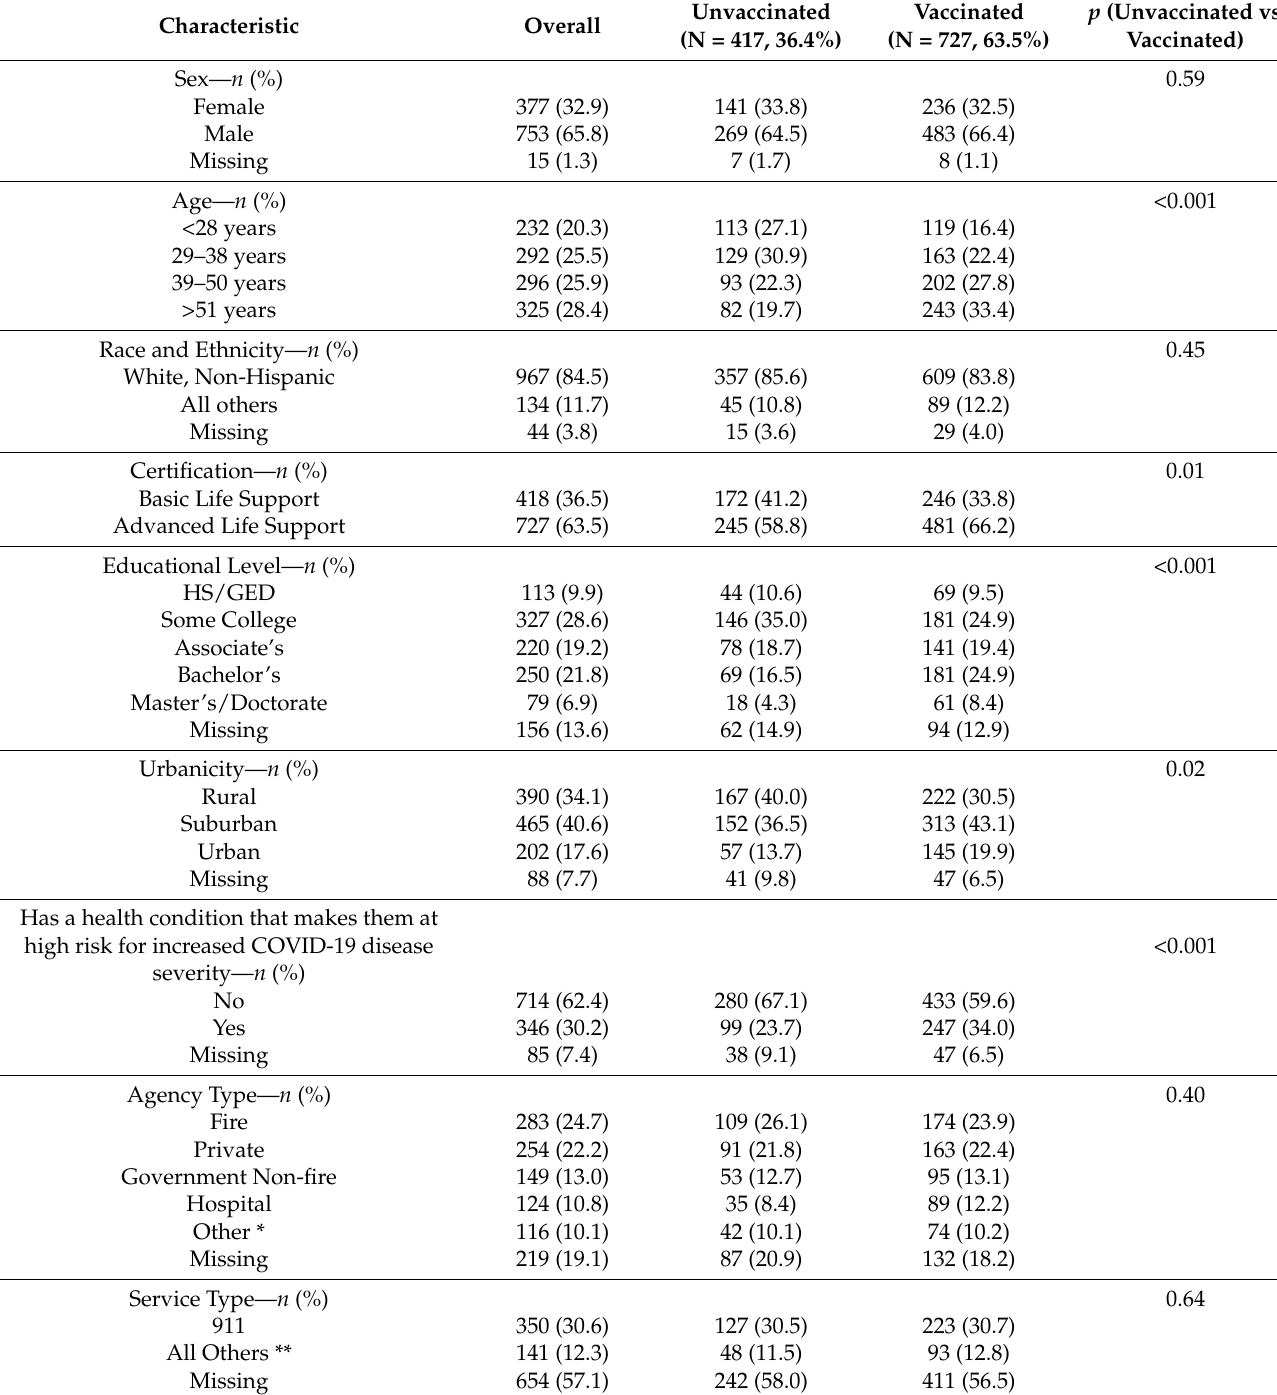
Table 1. Demographics of participants who provided at least one open-ended